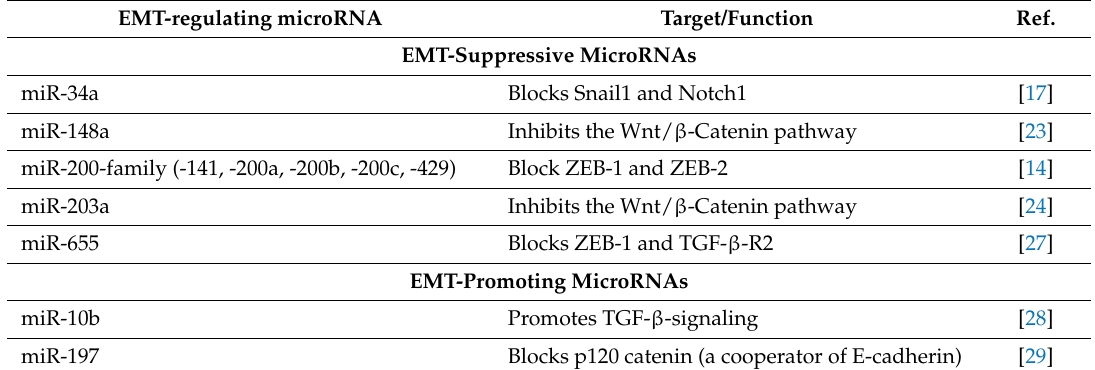
Table 3. Analyzed Epithelial-to-Mesenchymal Transition (EMT)-miRs and their